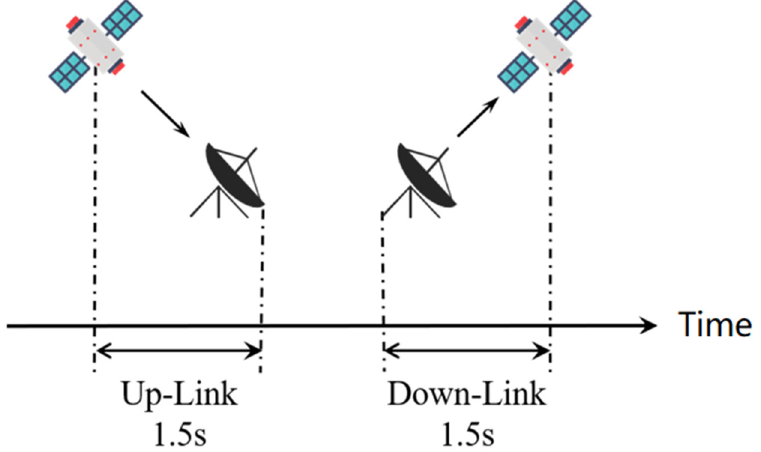
Figure 1. Transmit/receive time-sharing model of satellite-ground link.